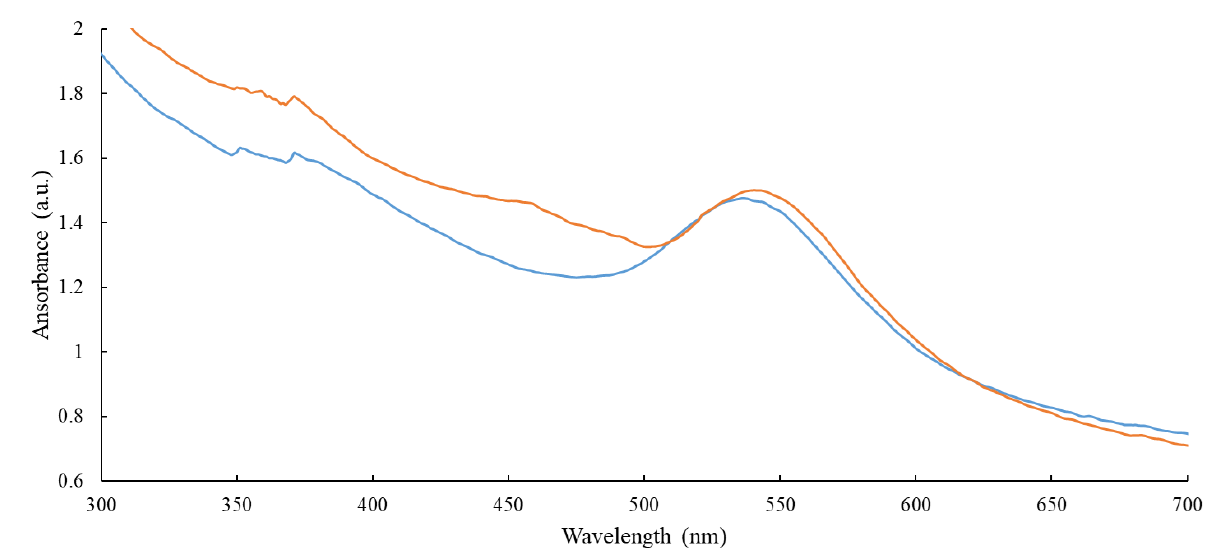
Figure 3. An overlay of the full spectrum UV-Vis scans obtained for AuMNPs, before and after conjugation to an NTR. The blue line represents the AuMNPs prior to conjugation ( λ -max = 536 nm) and the orange line represents the AuMNP-NTR conjugate ( λ -max = 540 nm).